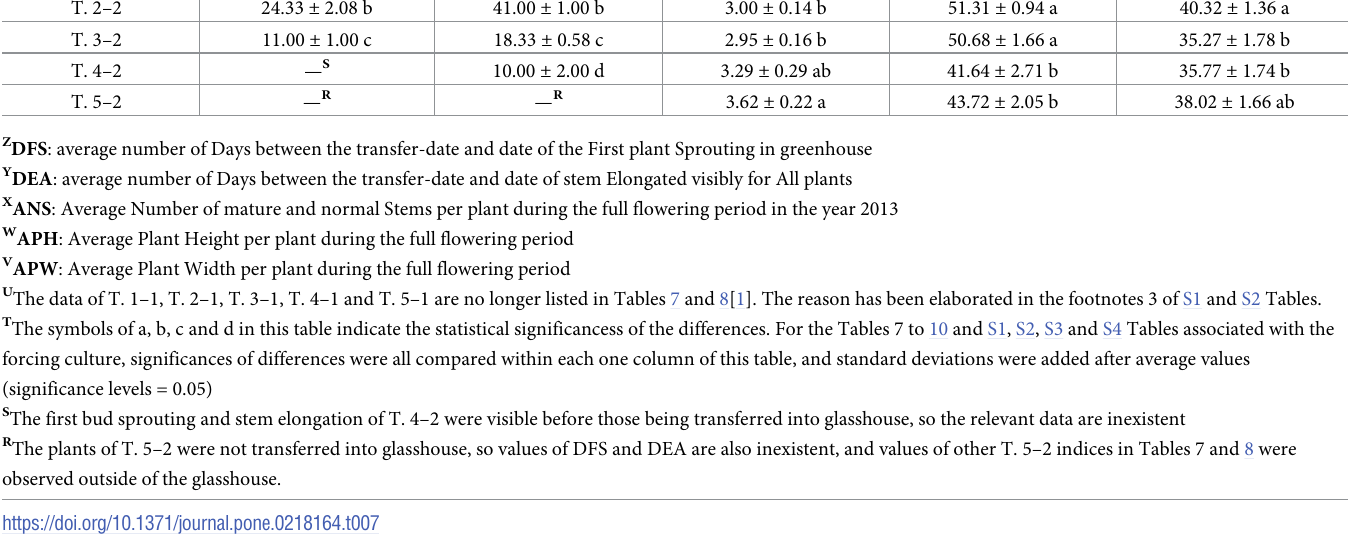
Table 7. Observation of the bud break and growth of ‘Hang Baishao’ after transfer into a glasshouse with natural chilling and 5-azacytidine treatments.